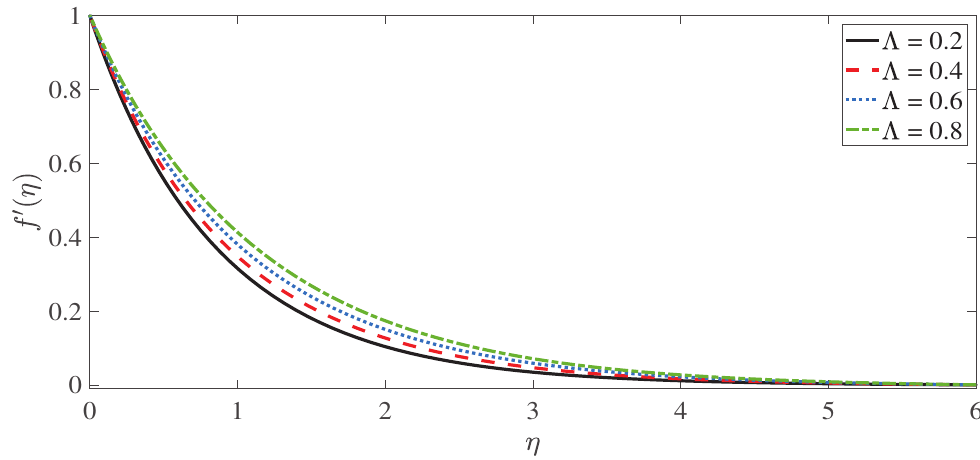
Figure 9. Velocity profile for mixed convection parameter Λ